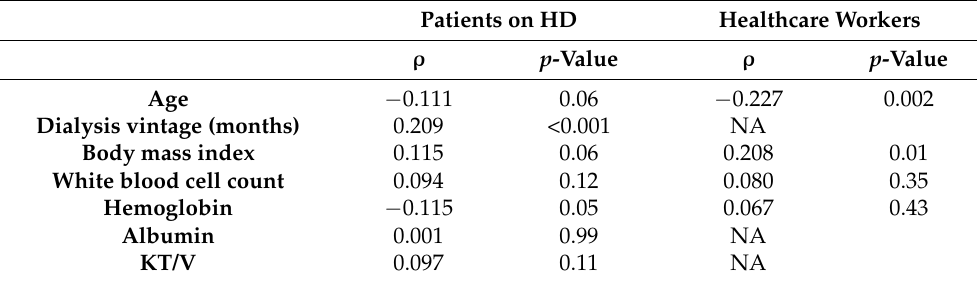
Table 4. Correlation between continuous parameters and anti-spike immunoglobulin G antibody levels 3 weeks after the third dose of